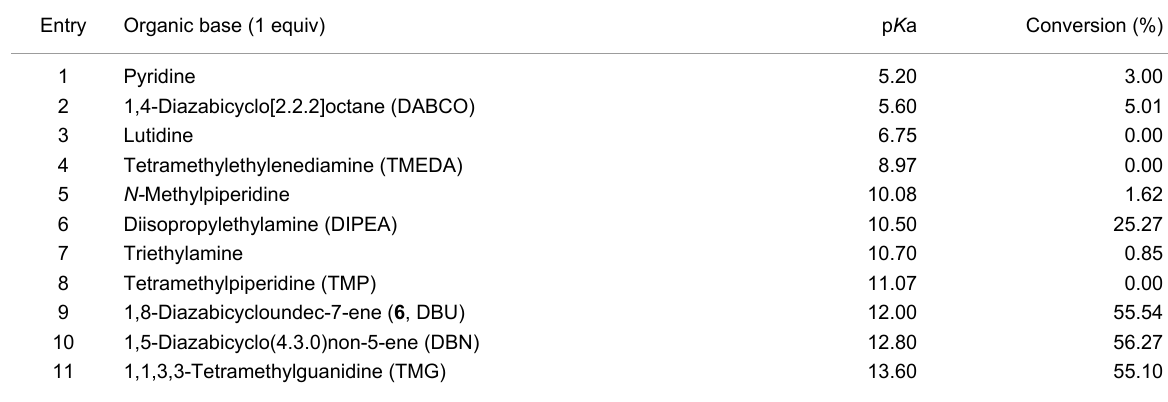
Table 1: Illustration of the organic bases investigated, ranked in order of increasing basicity and the conversion to diaryl ether 7 obtained when 1 equiv of base was used (residence time = 30 s; reactor temperature = 195